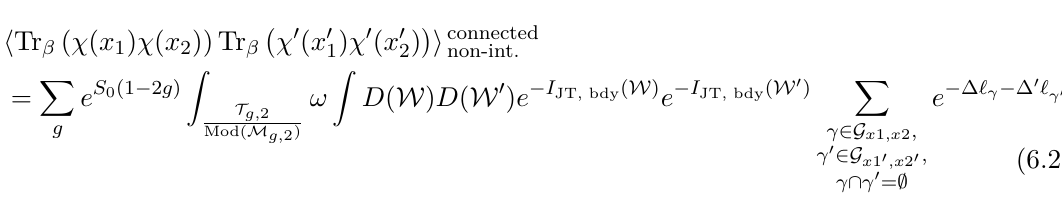
Figure 4 . An example (with genus 3) of the type of hyperbolic surfaces which the path integral (6.2) sums over. The figures represent the cuts M g, 2 → M h h 1 + h 2 ≤ g (top left), M g, 2 → M h, 1 ⊕ M g − h − 1 , 3 (top right), M g, 2 → M h, 2 ⊕ M g − h − 1 , 2 (bottom left), and M g, 2 → M g − 2 , 4 (bottom